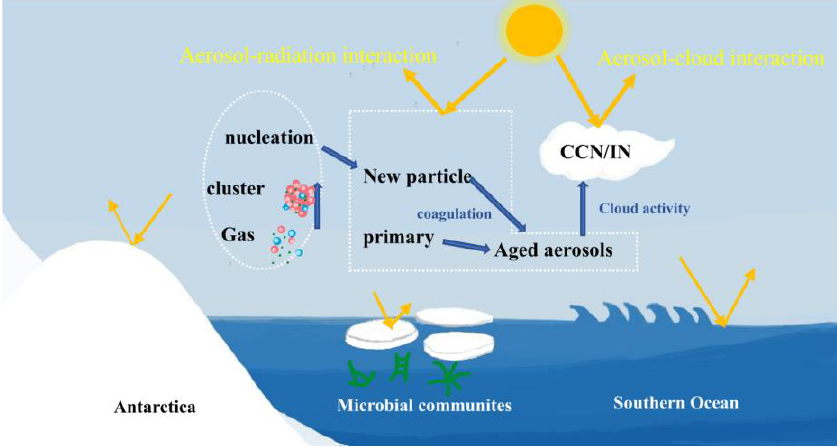
Figure 2. New particle formation over the SO and Antarctica and their effects on radiation.